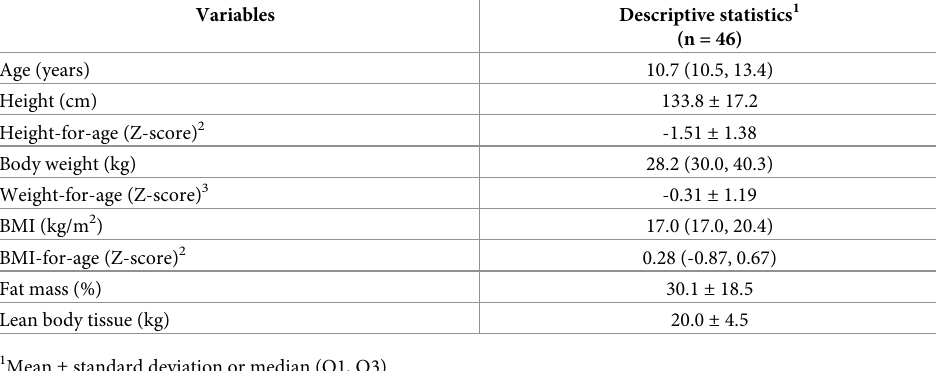
Table 2. Anthropometric characteristics of the boys with Duchenne muscular